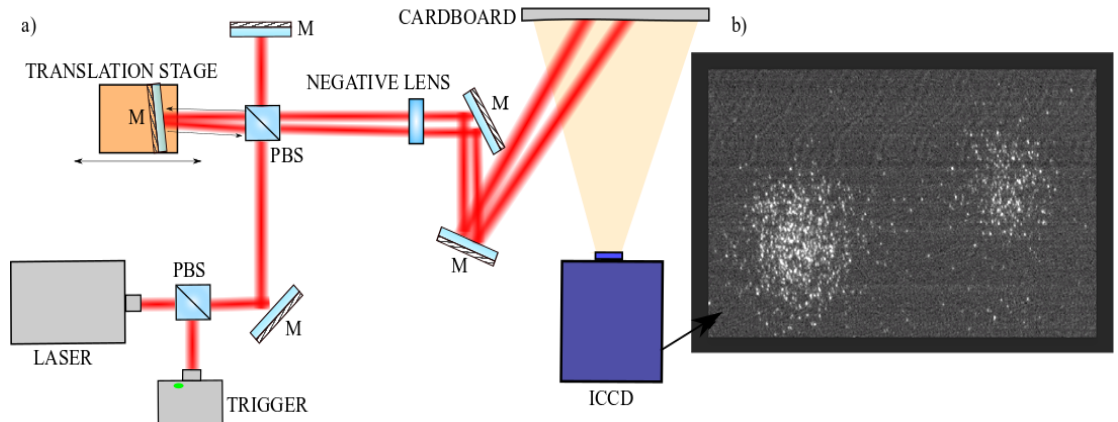
Figure 2. ( a ) A pulse is split with a beam splitter to hit two different mirrors, one of which is kept stationary while the other is moved by a translation stage, 3 mm at a time with respect to the first mirror. The two pulses are then redirected to pass through a diffuser and a negative lens to hit a cardboard in front of the field of view of the camera. One pulse thus hits the camera’s gate response at the same voltage value each time, while the second pulse, moved with the translation stage, hits a different voltage value each time the translation stage is moved. ( b ) The resulting image from the ICCD is displayed. One beam appears brighter/dimmer as it hits a higher/lower voltage of the camera’s gate